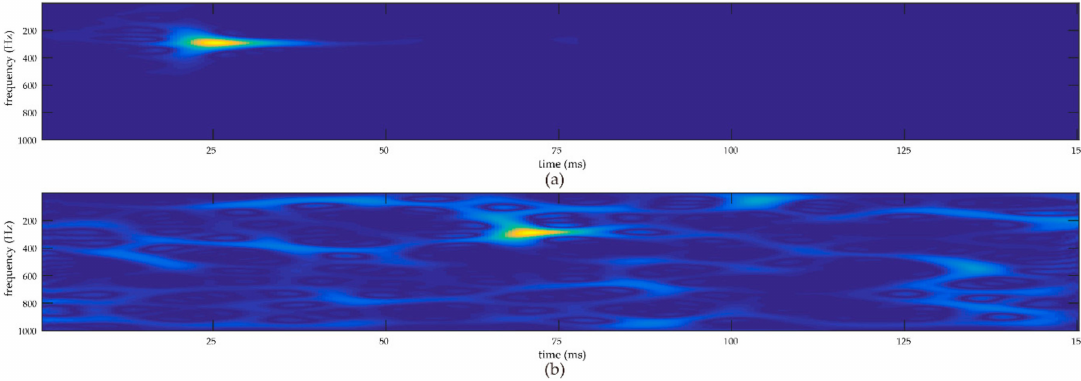
Figure 3. The time-frequency representations of two traces: ( a ) the result of time-frequency transform of Trace 1; ( b ) the result of time-frequency transform of Trace